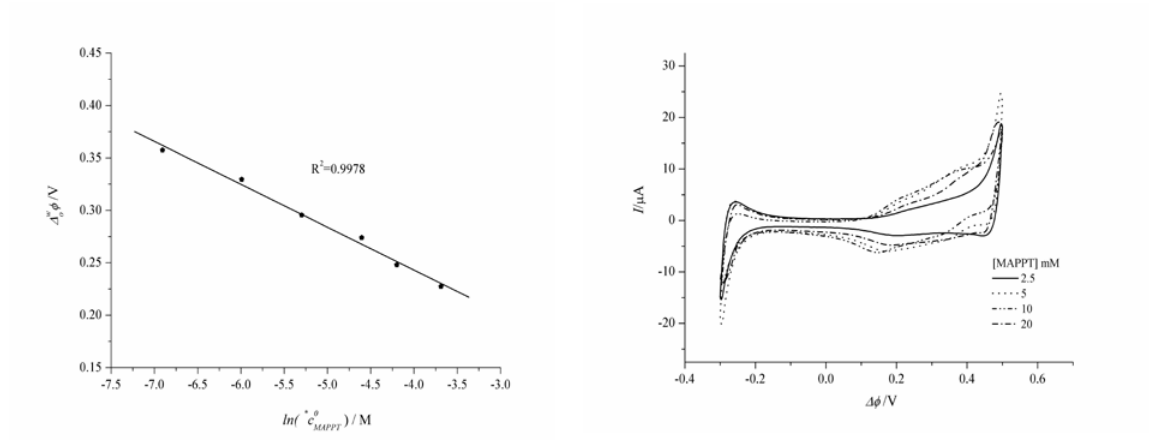
Figure 6. Dependence of the half wave potential on the initial concentration of MAPPT in the 1,2-DCE phase for assisted Cd 2+ transfer.